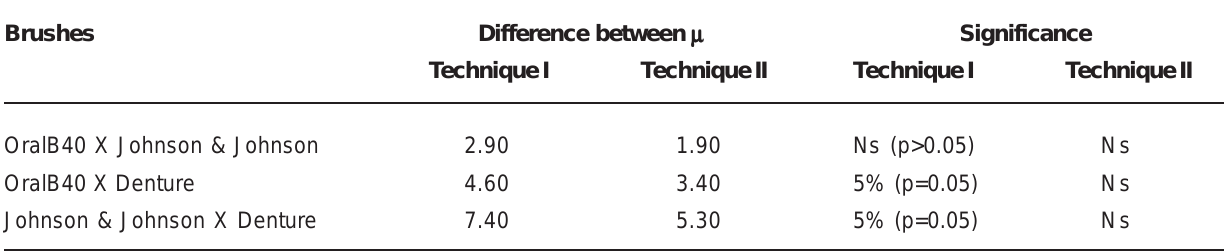
(Ns): non-significant